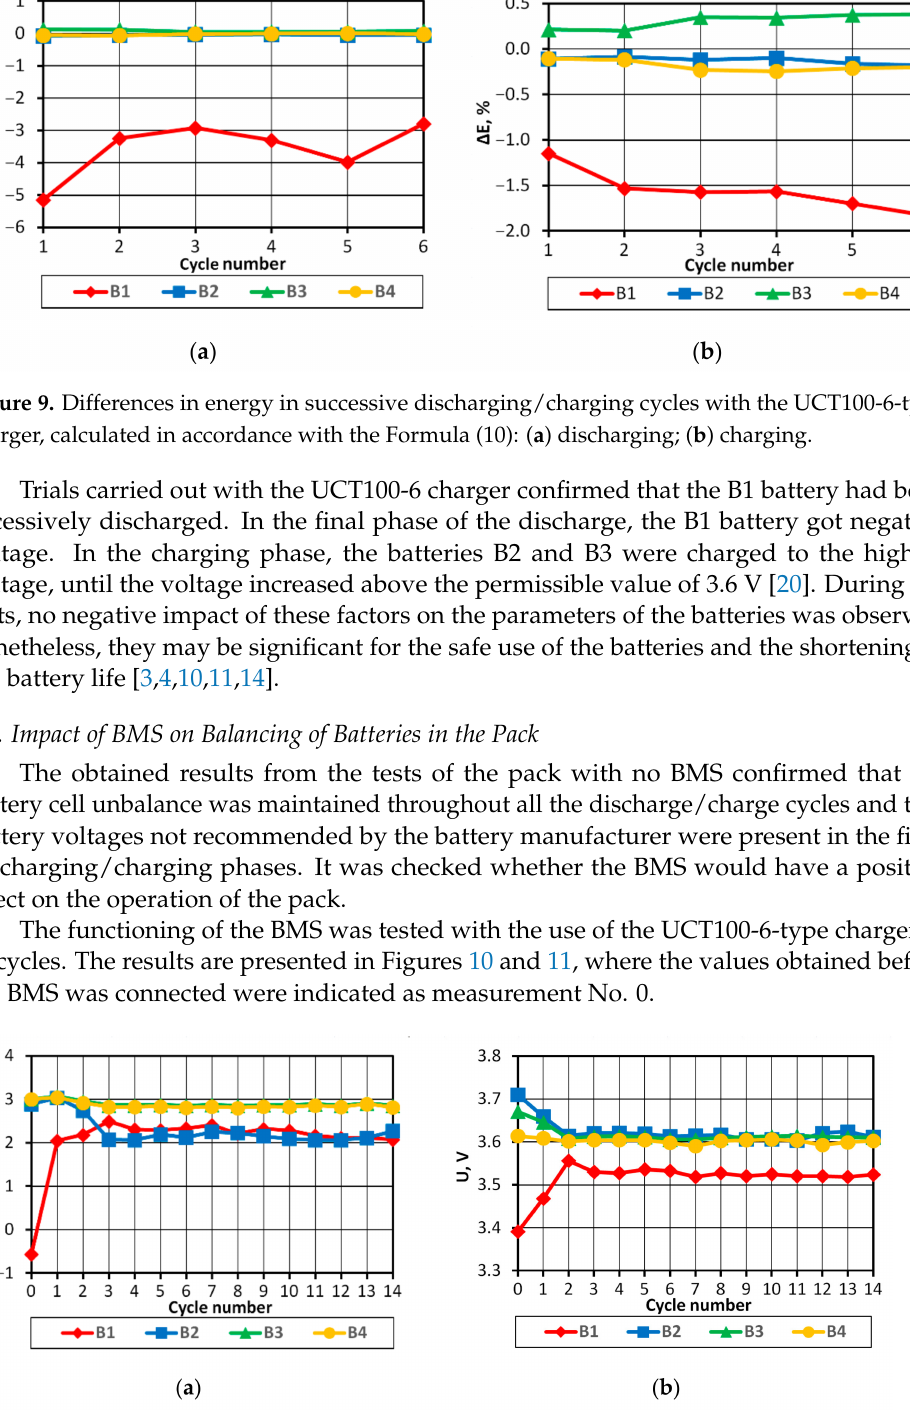
Figure 10. Battery voltages of the packs with the BMS at the end of successive discharge/charge cycles: ( a ) end of discharge; ( b ) end of